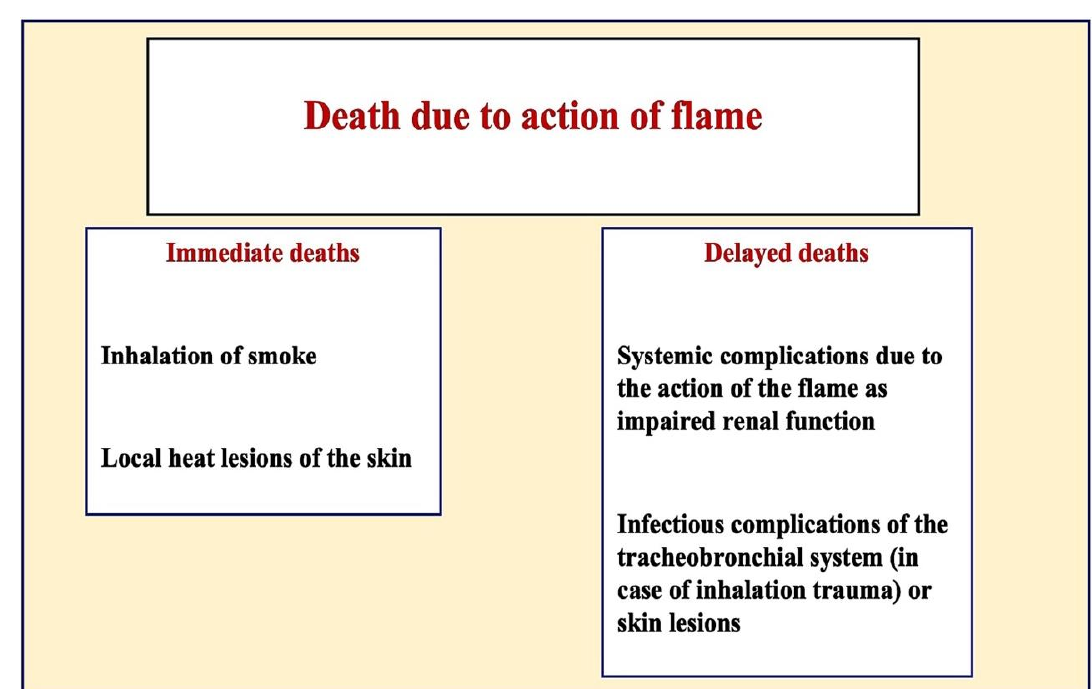
Figure 1. The flowchart illustrates the method for selecting cases of interest from all potentially identified cases.